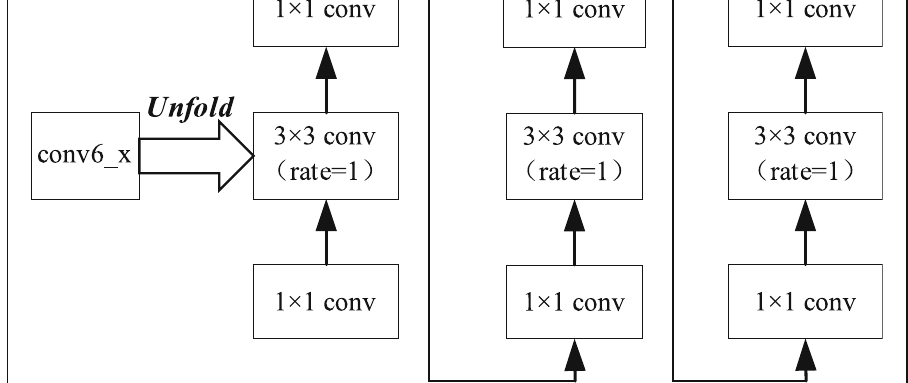
Fig. 7 Structure diagram of hybrid dilated